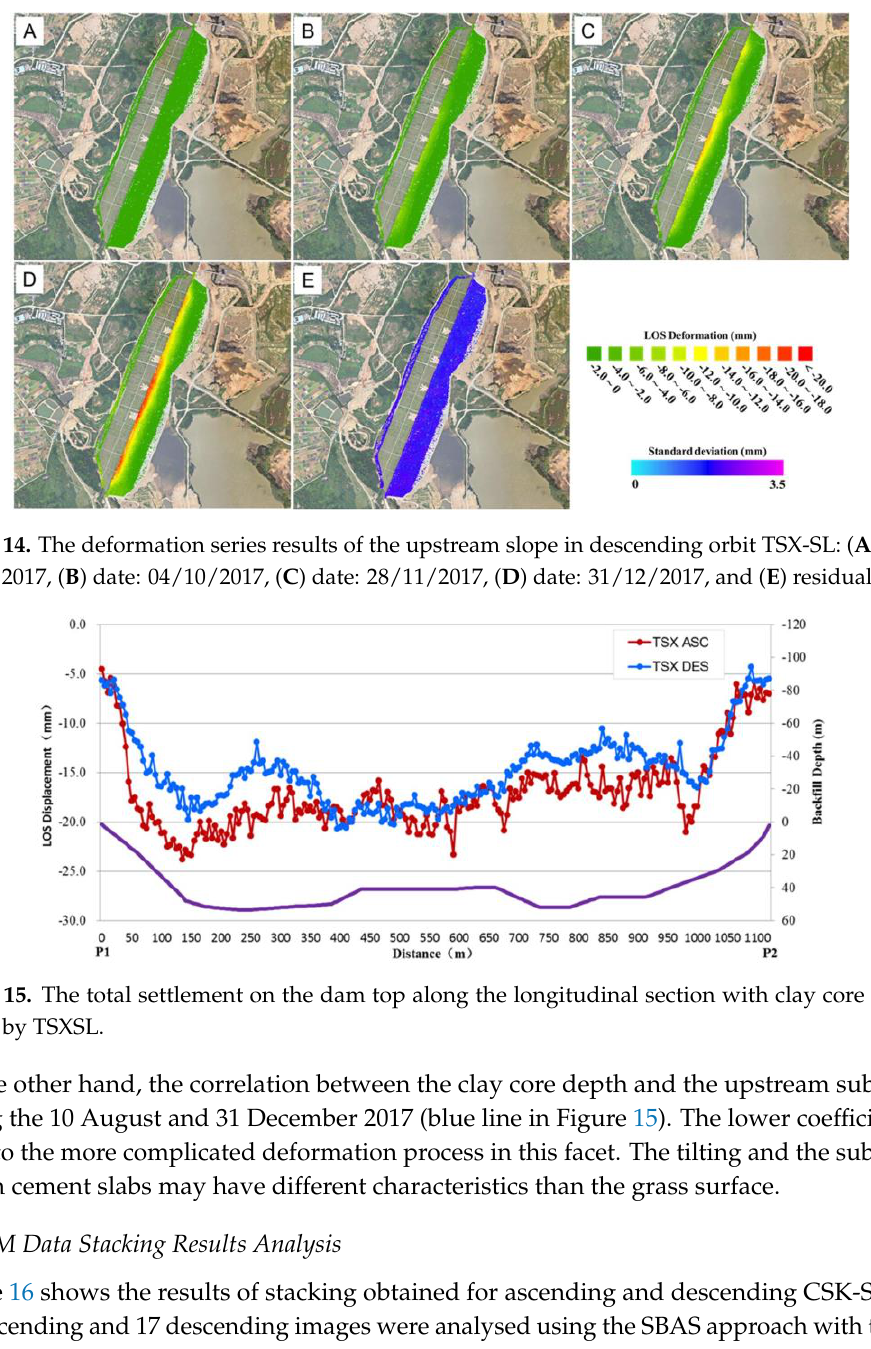
Figure 15. The total settlement on the dam top along the longitudinal section with clay core depth curves by TSXSL.